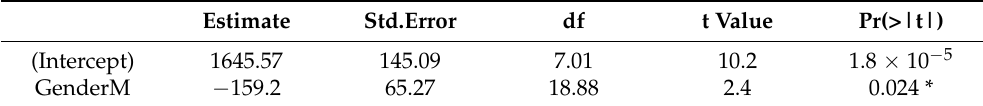
Table 5. Fixed effects of gender on F2.